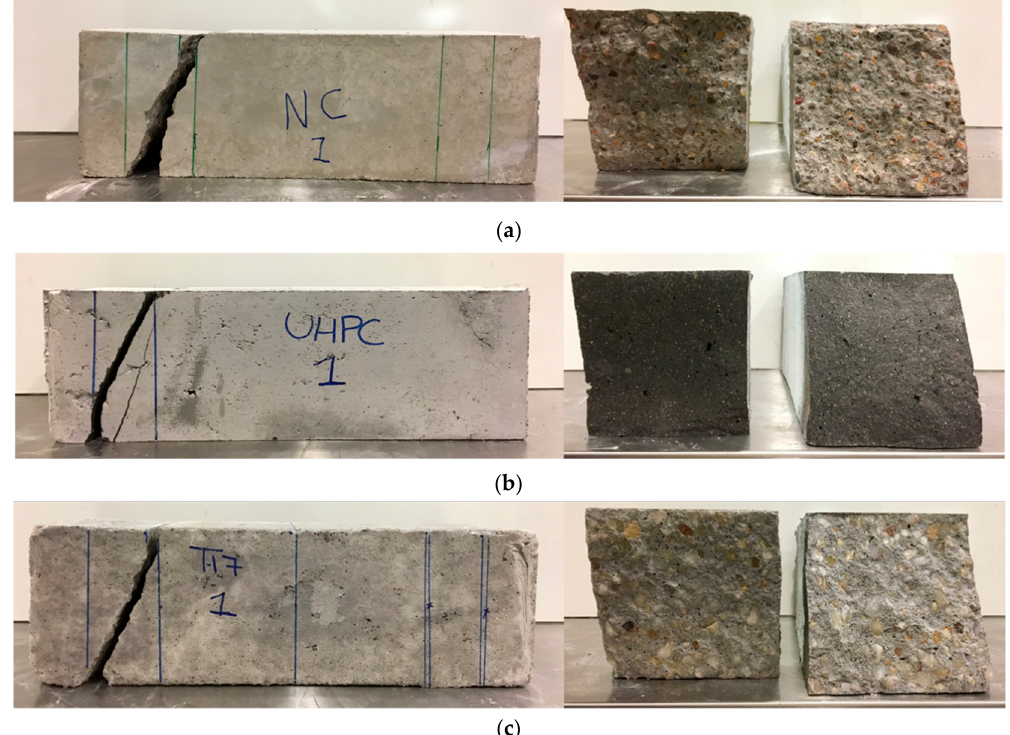
Figure 10. Shear failure of: ( a ) Normal concrete (NC); ( b ) Ultra High Performance Concrete; ( c ) PMMA-PC.